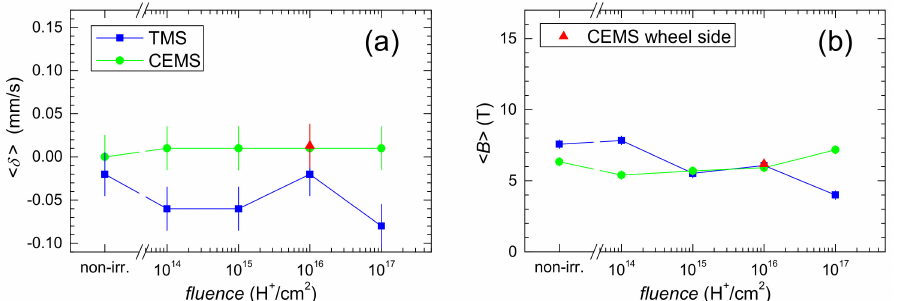
Figure 2. Parameters derived from transmission (TMS, blue) and CEMS (green) Mössbauer spectra of Fe 76 Mo 8 Cu 1 B 15 irradiated by 80 keV H + ions plotted against the ion fluence: ( a ) Average isomer shift, (cid:104) δ (cid:105) ; ( b ) average hyperfine magnetic field, (cid:104) B (cid:105) . Red triangles correspond to CEMS spectrum taken from the wheel side of the ribbons. Solid lines are only guides for the eye.